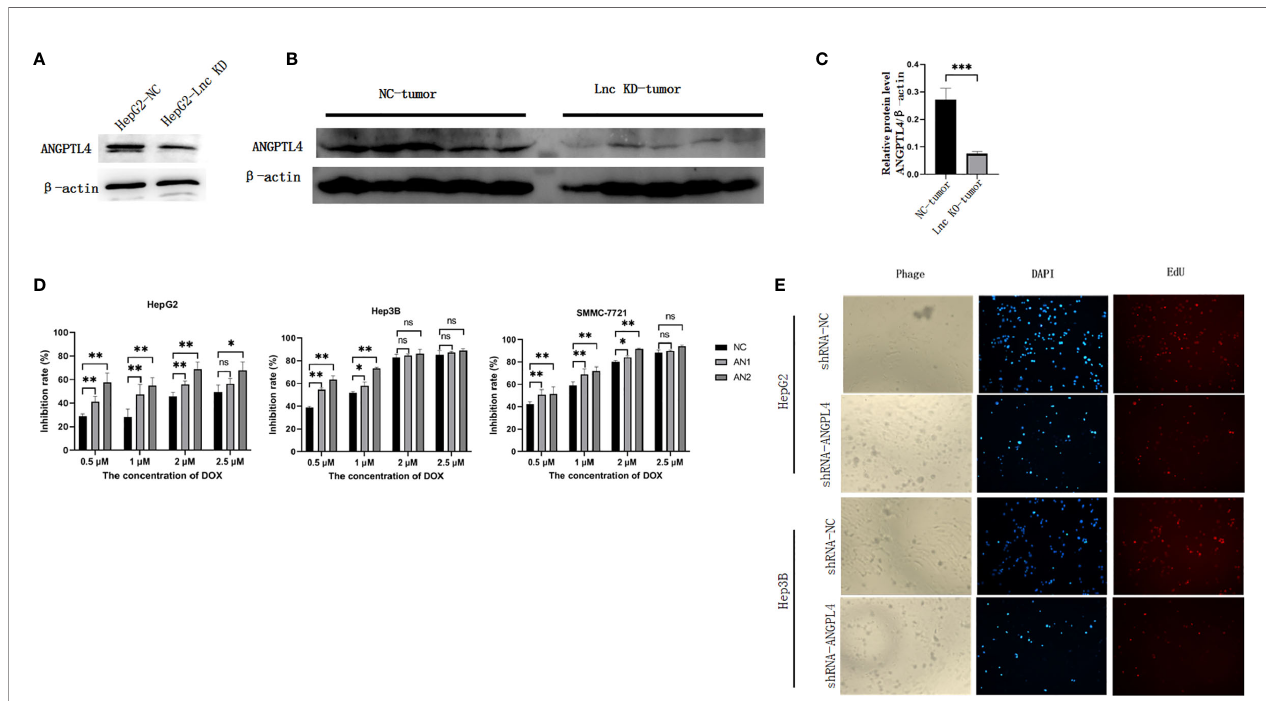
FIGURE 7 | The role of ANGPTL4 in hepatocellular carcinoma cells. (A) The protein expression of ANGPTL4 in HepG2 cells after transfection of NC siRNA or siRNA3 (n=5). Protein (B) or RNA (C) expression of ANGPTL4 in HepG2 xenografts. (D) Knocking down of ANGPTL4 using ANGPTL4-siRNA 1 (AN1) or ANGPTL4- siRNA 2 (AN2) increased the inhibition of Doxorubicin in HepG2, Hep3B, and SMMC-7721 cells. (E) EdU analysis showing cell proliferation after transfection of scrambled shRNA (shRNA-NC) or shRNA-ANGPTL4 ( fi eld of view: 200x) in HepG2 or Hep3B cells treated with 2.5 µM doxorubicin for 48 hours. *p < 0.05, **p < 0.01, ***p < 0.001; ns, not statistically signi fi